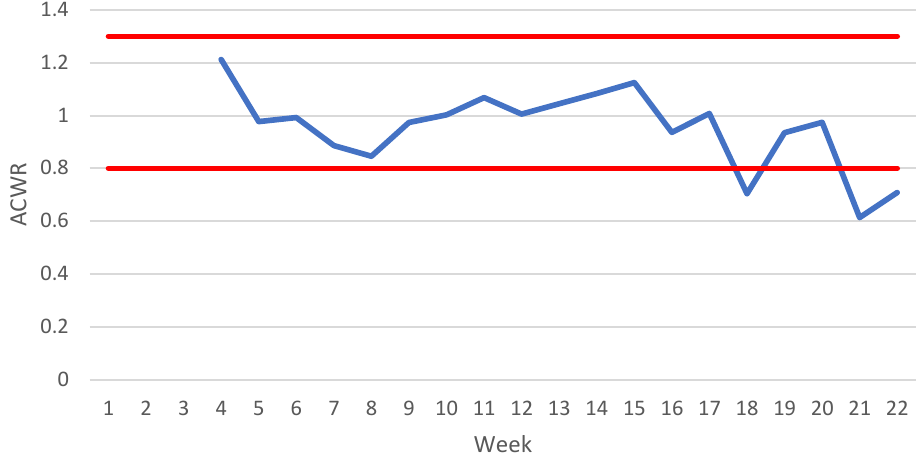
Figure 4. Average ACWR of distance covered across seven academy classes. Key: Red lines signify 0.80 – 1.30 optimal range as proposed by Gabbett [20]; ACWR, acute:chronic workload ratio.